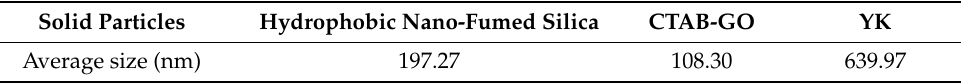
Table 3. Average particle size of three solid particles. Solid Particles Hydrophobic Nano-Fumed